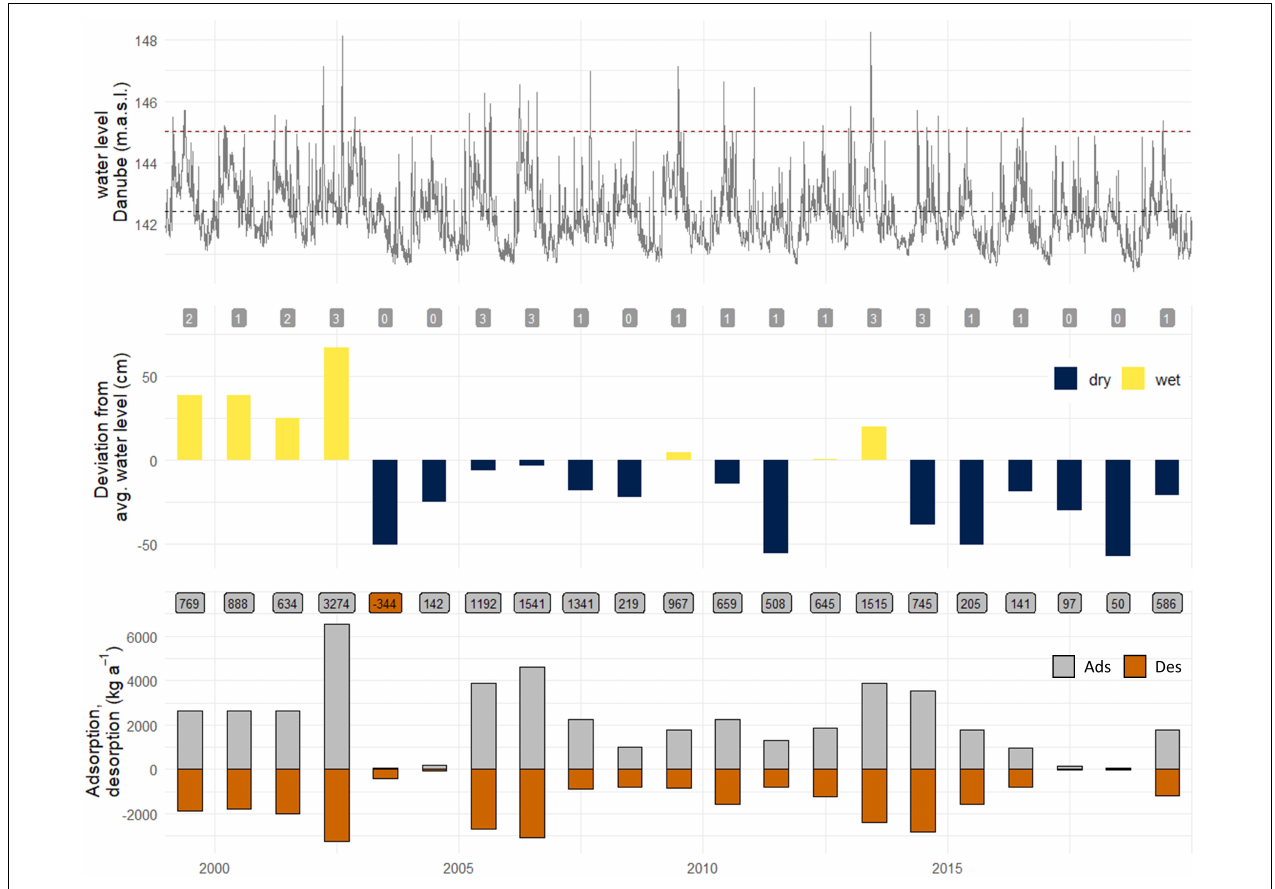
FIGURE 5 | Riverine water level and corresponding adsorption/desorption potential of all floodplain water bodies from 1999 to 2019. Water level of the main channel of the Danube; dashed line—mean water level (MW2010, KWD 2010). Number of floods per year is indicated (gray boxes). Deviation from average water level calculated as the difference between the average water level per year and the mean water level of the Danube (MW 2010, KWD 2010). Adsorption/desorption potential of the whole floodplain per year; labels indicate net adsorption (gray) or release (orange) of SRP are shown in boxes.